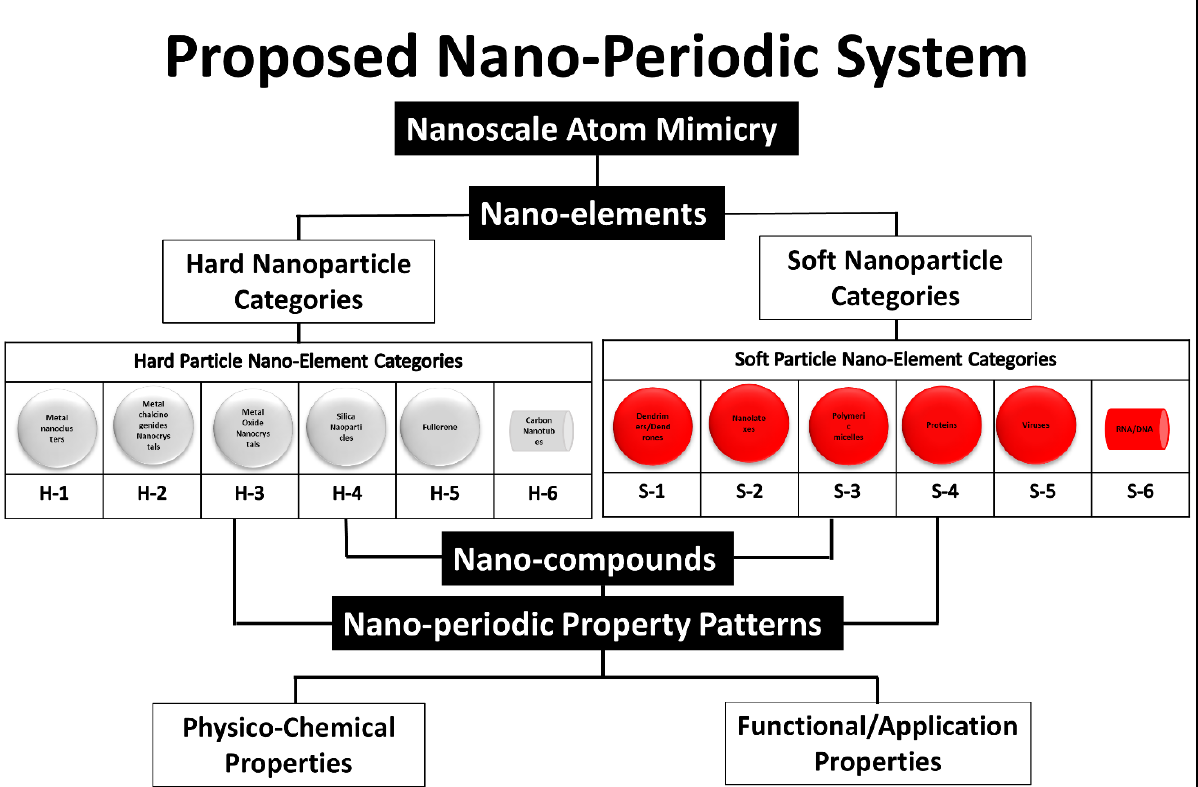
Figure 7. Proposed nano system by Donald Tomalia. The figure has been reproduced from another article [10] under a CC − BY license.